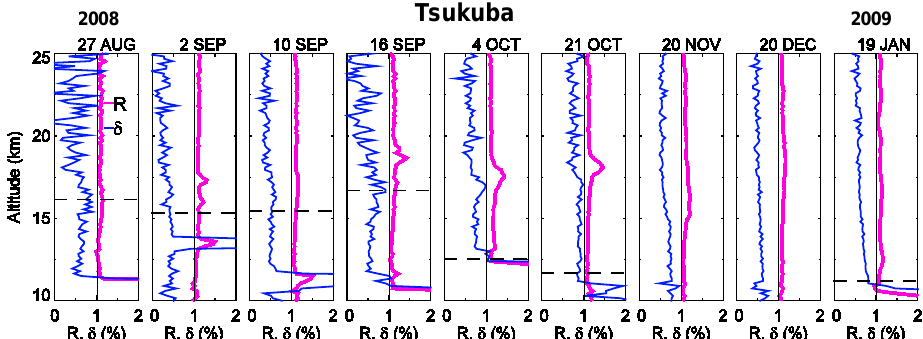
Fig. 6. Profiles similar to Fig. 1 over Tsukuba from August 2008 to January 2009 after the 2008 Kasatochi eruption.